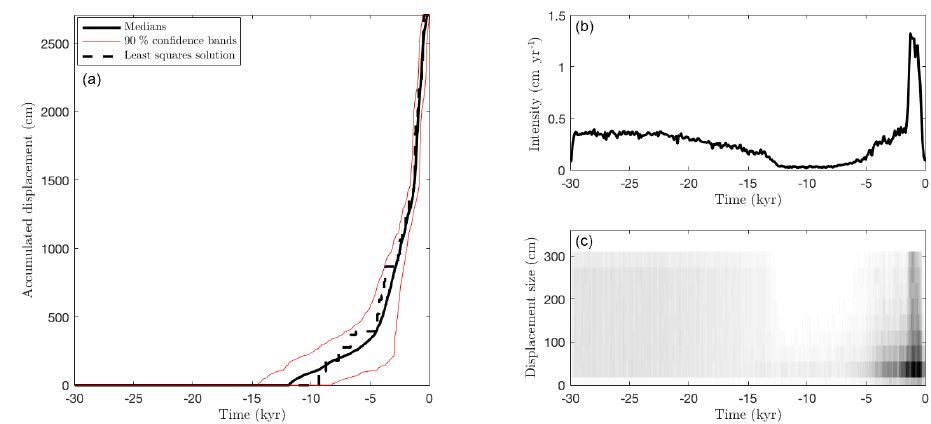
Figure 11. Fiamignano fault: the accumulated displacement (a) , the mean earthquake intensity (b) and an event scatter plot (c) showing events from posterior samples (with gray scale to indicate frequencies).